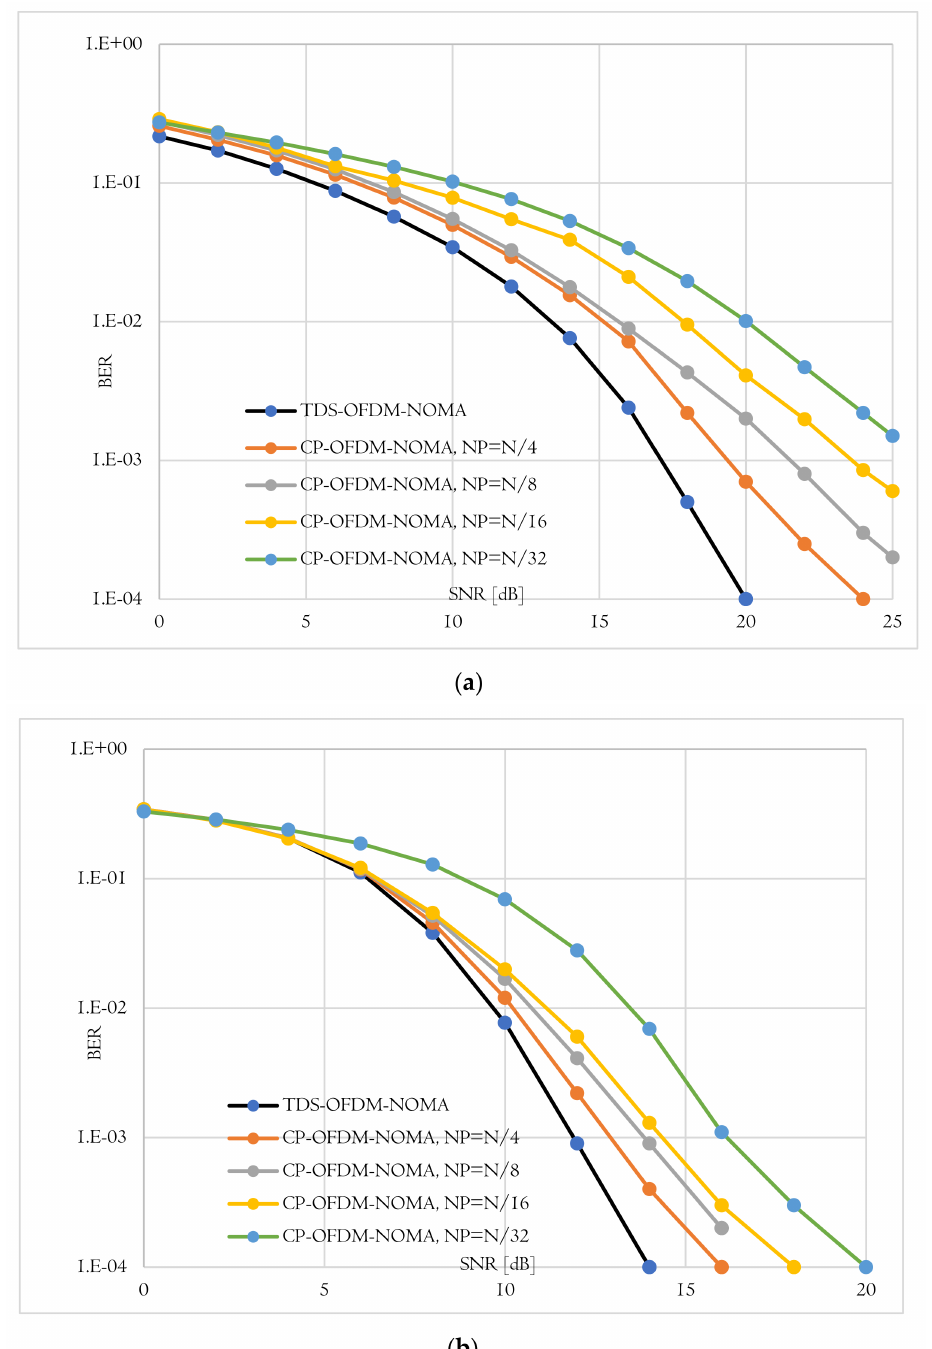
Figure 10. BER-(near-user) comparison of proposed TDS-OFDM-NOMA and convention CP-OFDM- NOMA; ( a ) Uncoded system and ( b ) Coded